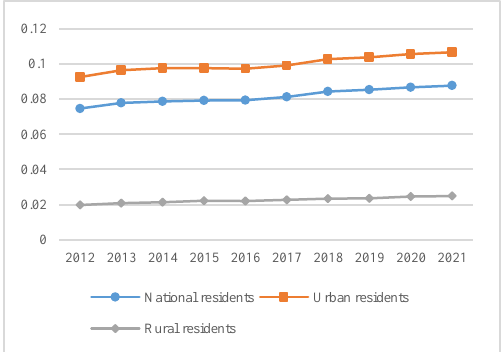
Figure 1. Residents’ property income as a proportion of disposable income.